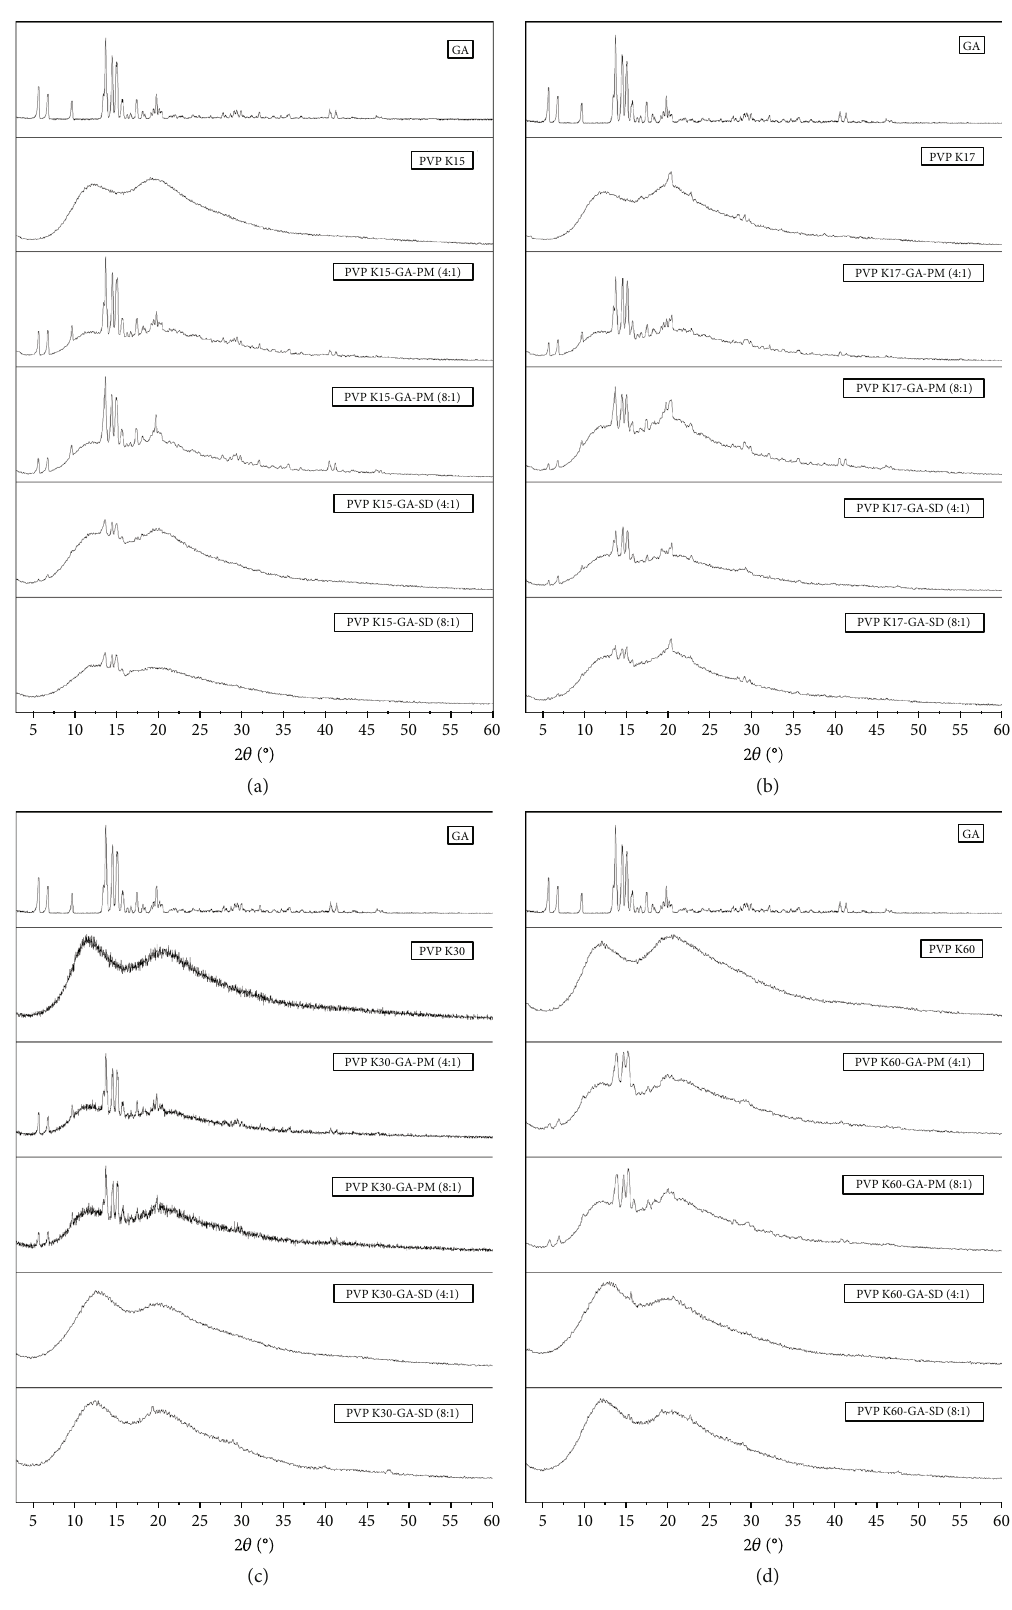
Figure 4: X-ray di ff ractogram of SDs and PMs of GA prepared using (a) PVP K15, (b) PVP K17, (c) PVP K30, and (d) PVP